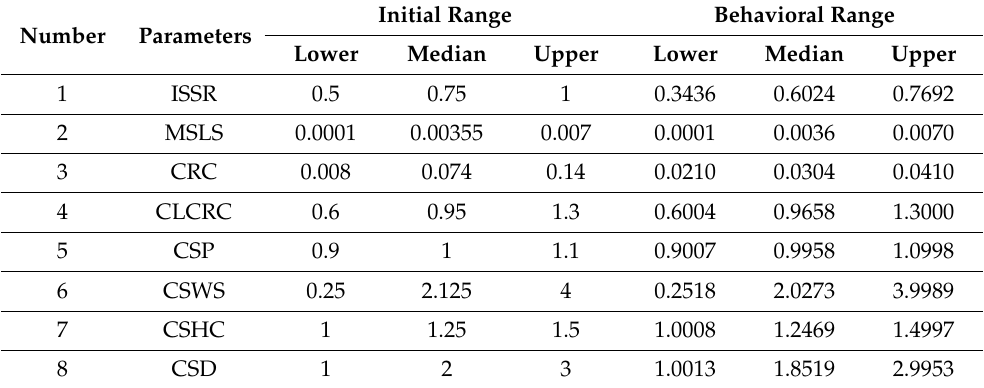
Table 10. L 4 − based parameter range of behavioral models.